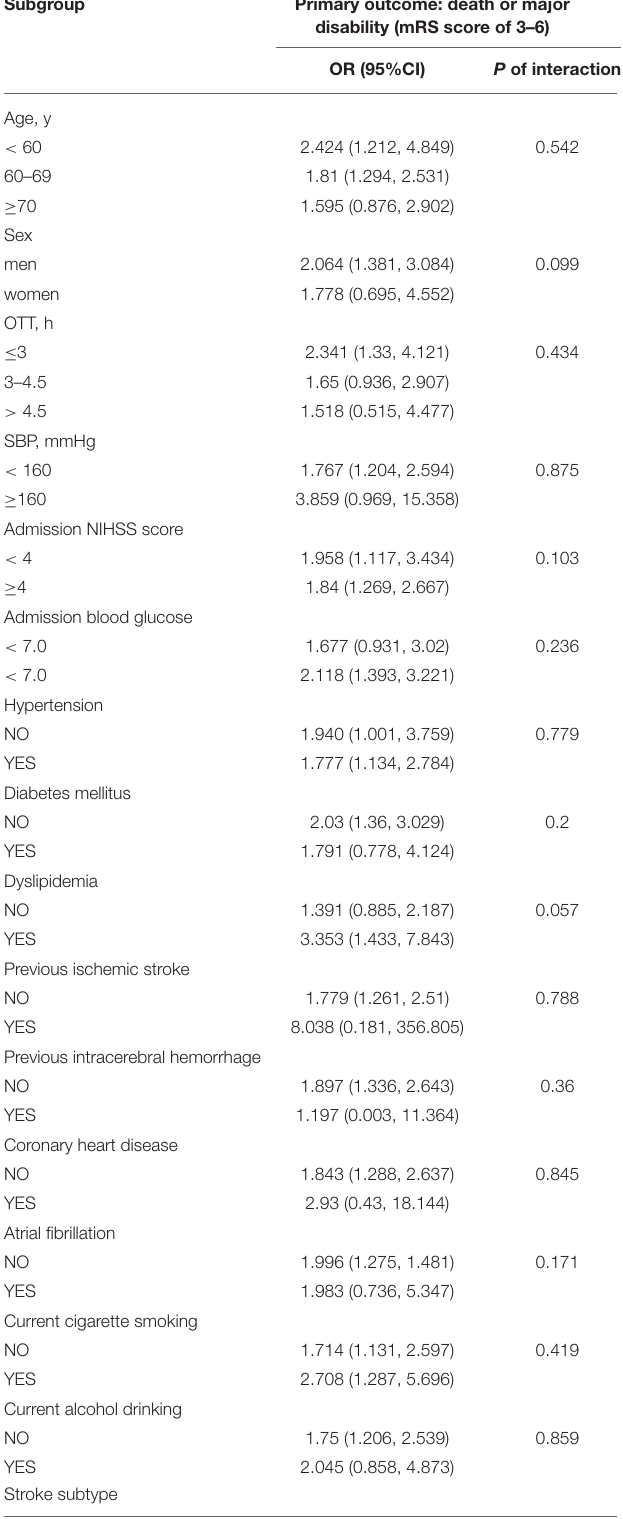
TABLE 4 | Subgroup analysis of the association between LDH before thrombolysis and primary outcome (death or major disability). Subgroup